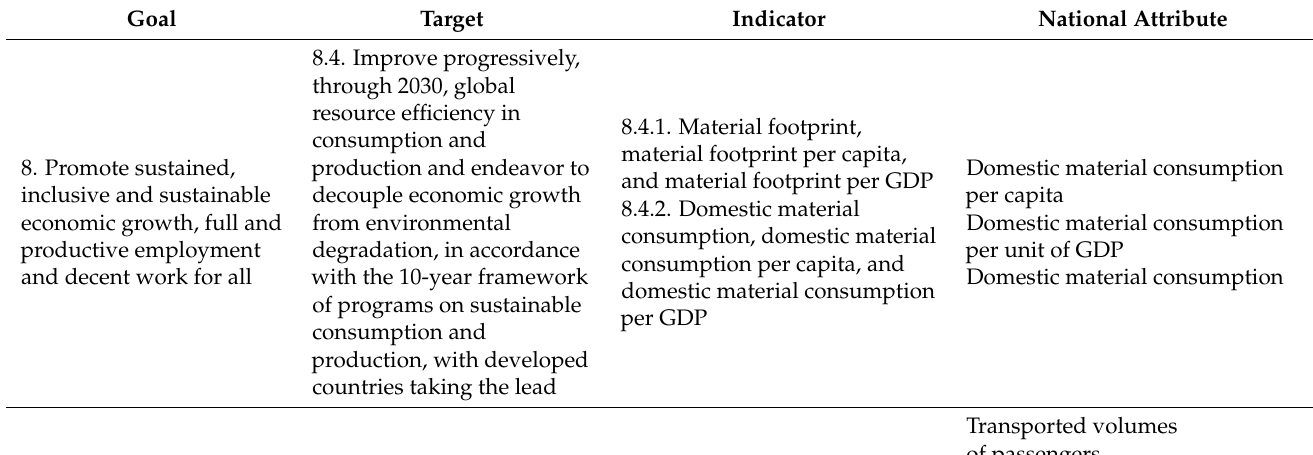
Table 2. Agenda 2030 indirect indicators to mobility (economic and